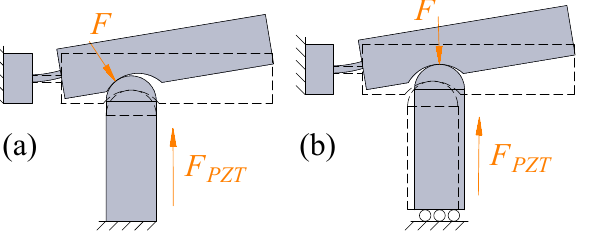
Figure 4. Comparison of different contact ways of a piezoelectric actuator: ( a ) traditional lever mechanism and ( b ) designed hybrid mechanism.